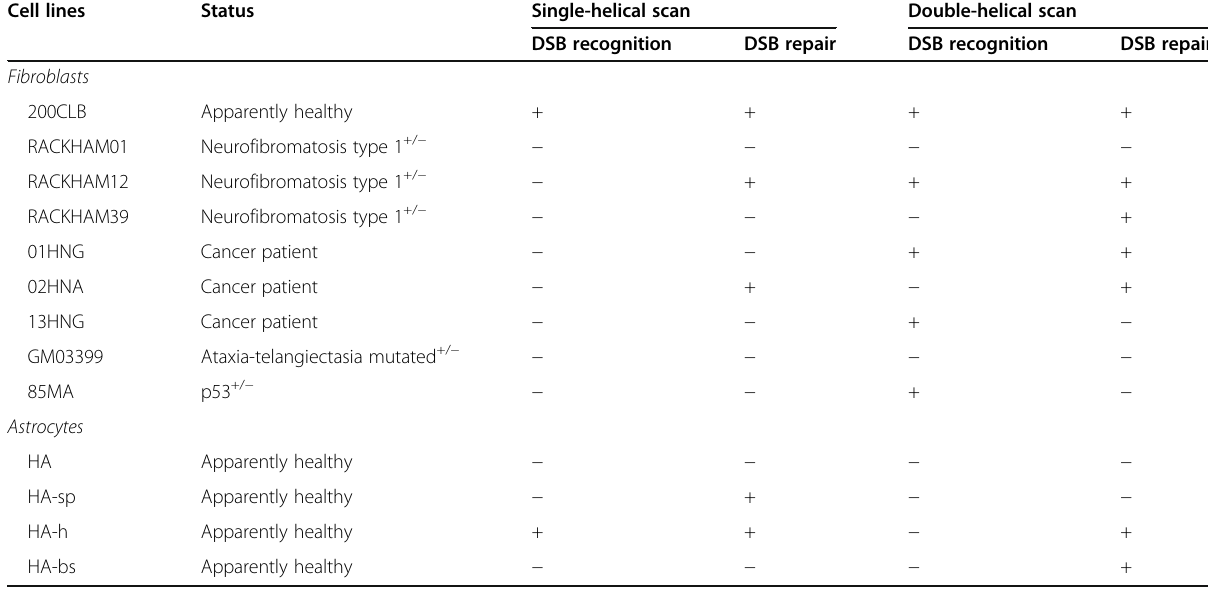
Table 2 Major clinical features of the cell lines used in this study Cell